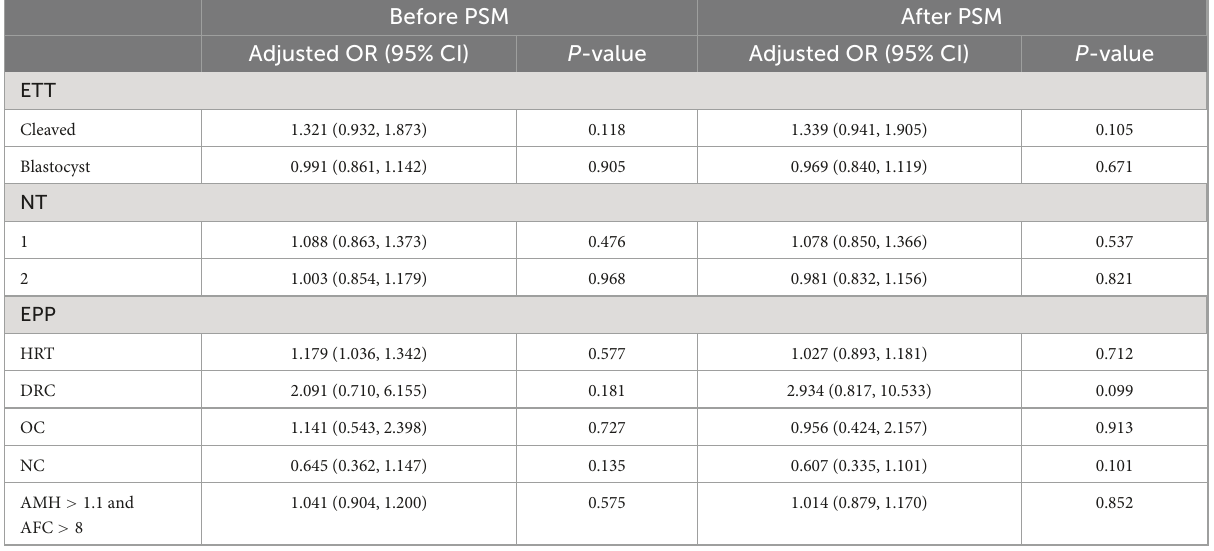
TABLE 5 Multivariate logistic regression analysis of live birth rates for immediate FET and delayed FET. Before PSM After